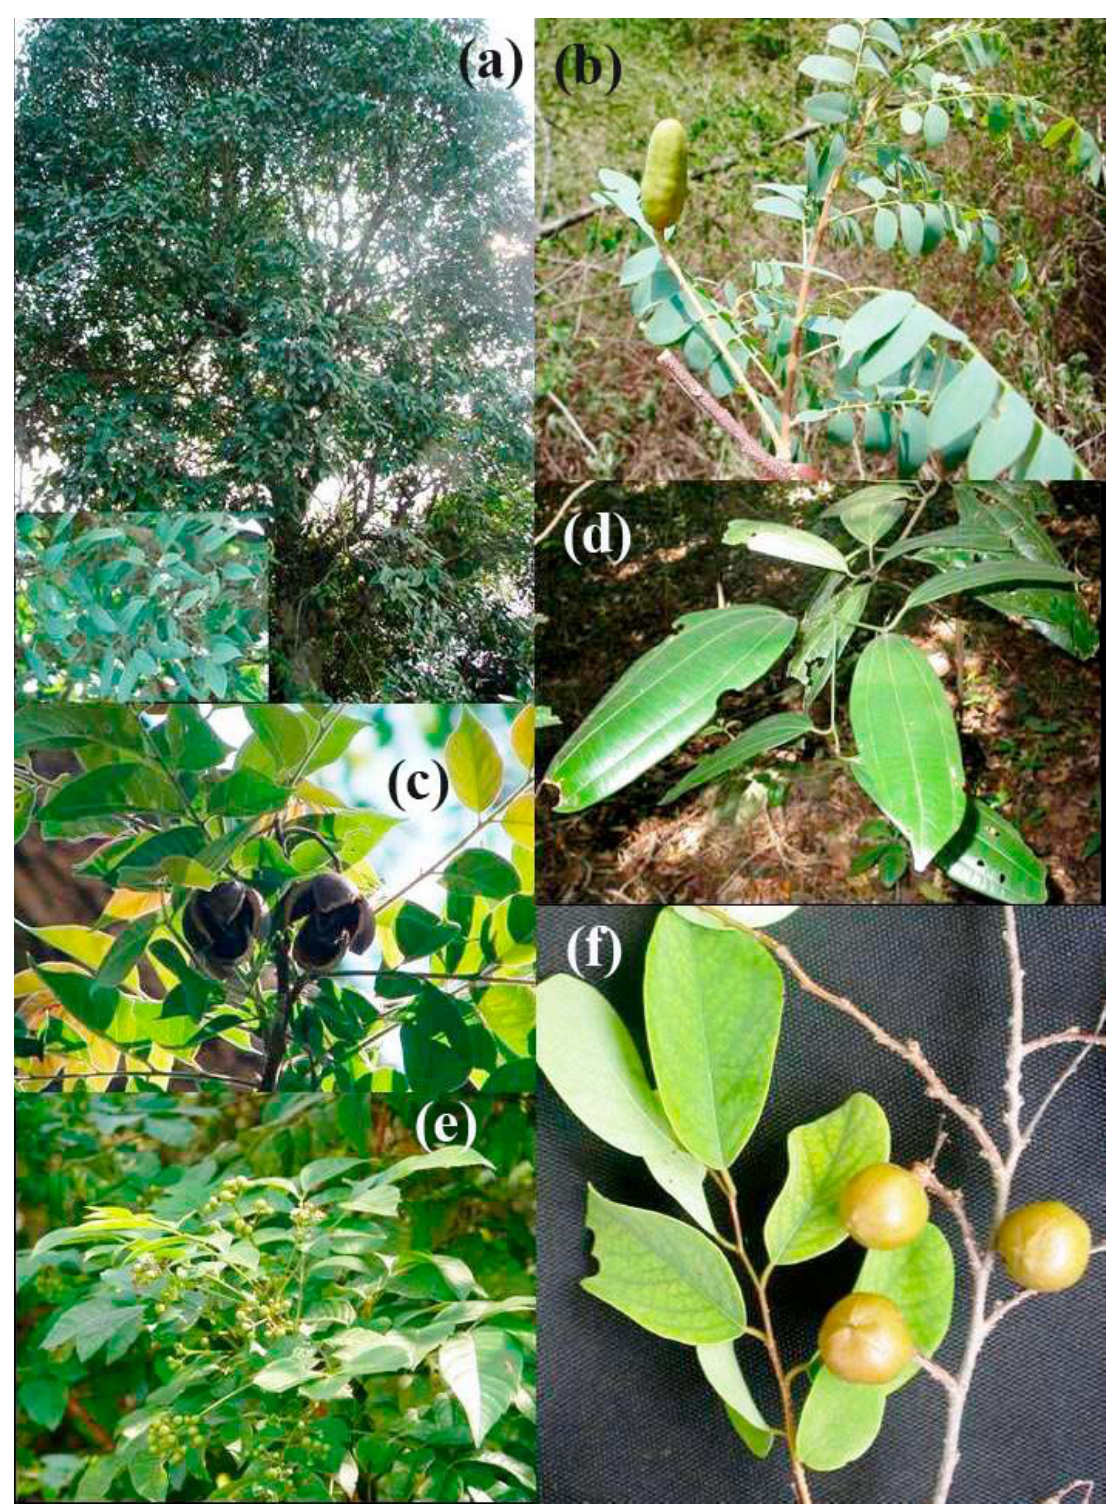
Figure 7. a) Celtis philippensis (Ulmaceae); b) Chloroxylon swietenia (Flindersiaceae); c) Chukrasia tabularis (Meliaceae); d) Cinnamomum malabatrum (Lauraceae); e) Cipadessa baccifera (Meliaceae); f) Cleistanthus collinus (Euphorbiaceae). Photo by L. Arul